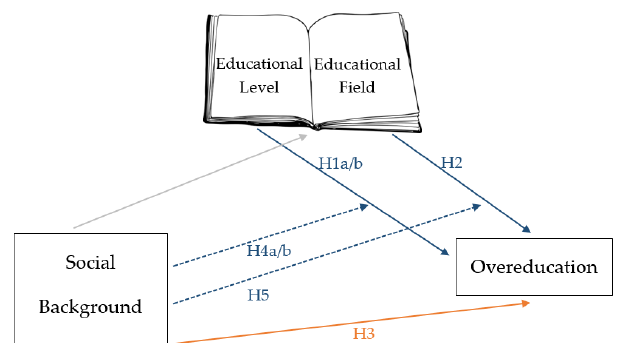
Figure 1. Overview of construct and hypotheses. Continuous blue and orange arrows present hypotheses for direct relationships and dashed blue arrows present hypotheses for interaction terms. The grey arrow is shown for the sake of completeness (relationship between social background and education) and it is not part of the analyses.